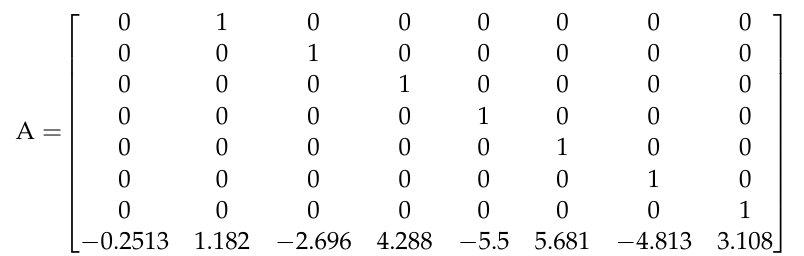
The Transfer Function: The Output Nonlinearity Function: No, of Poles and Zeros Type and Feature Piecewise function with 30 break-points for all For all Functions